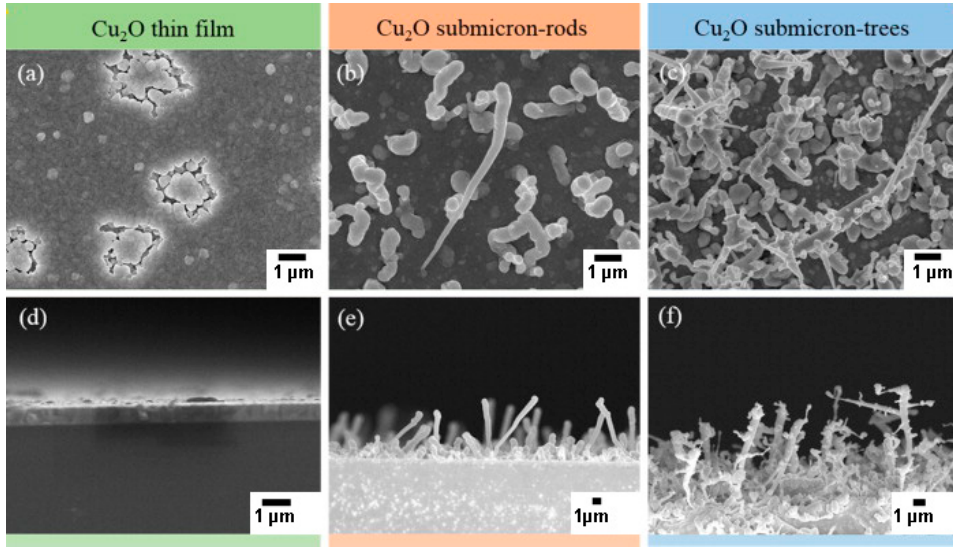
Figure 12. Top-view and cross-section FE-SEM images of Cu 2 O thin film ( a , d ), submicron-rods ( b , e ) and submicron-trees ( c , f ). Reproduced from Ref. [116] with permission from Elsevier, 2014.